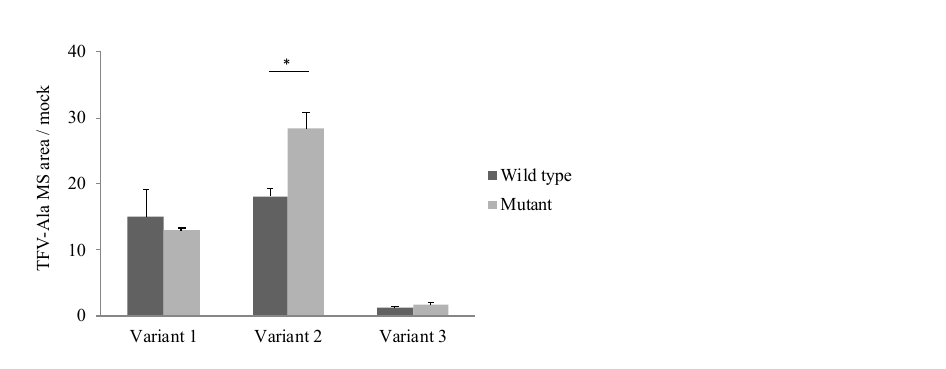
Figure 5. Metabolism of TAF to TFV-Ala in stably Cathepsin A expressing Flp-in 293 cells. Cells were incubated with 5 µ M TAF for 60 min. TFV-Ala in supernatants was quantified by LC-MS/MS. The data represented as mean + S.D. of triplicate experiments. ( t test * p <